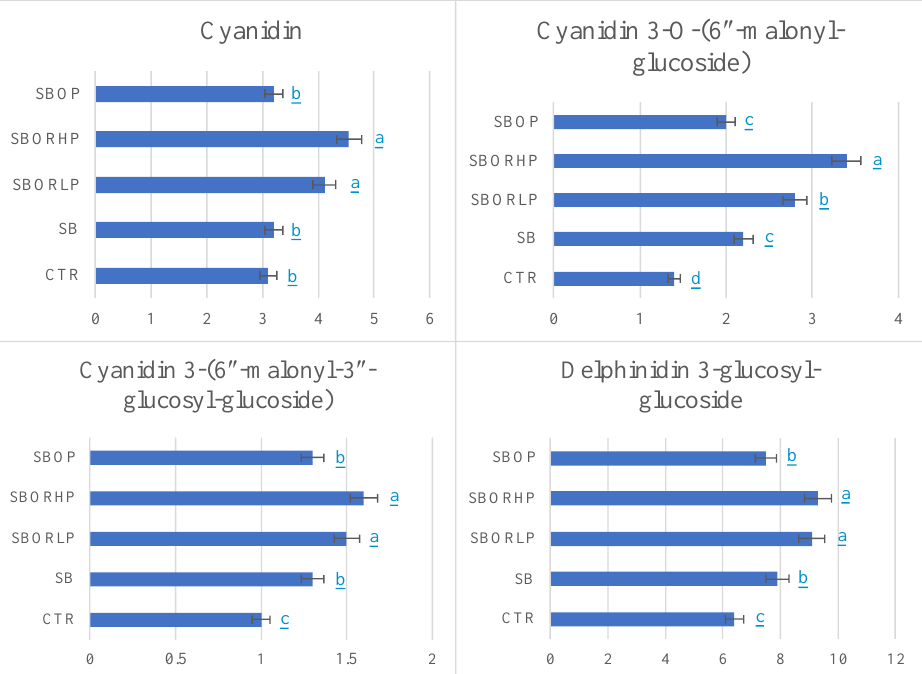
Figure 2. Anthocyanidins (mg ∙ 100 ∙ g − 1 FW) found in red onion bulbs differently fertilized: control (CTR), sulphur bentonite (SB), sulphur bentonite-low percentage orange residue (SBOR LP), sulphur bentonite-high percentage orange residue (SBOR HP), and sulphur bentonite-olive pomace (SBOP). Data are the mean of three replicates ± the standard error. Different letters indicate significant differences at p < 0.05.